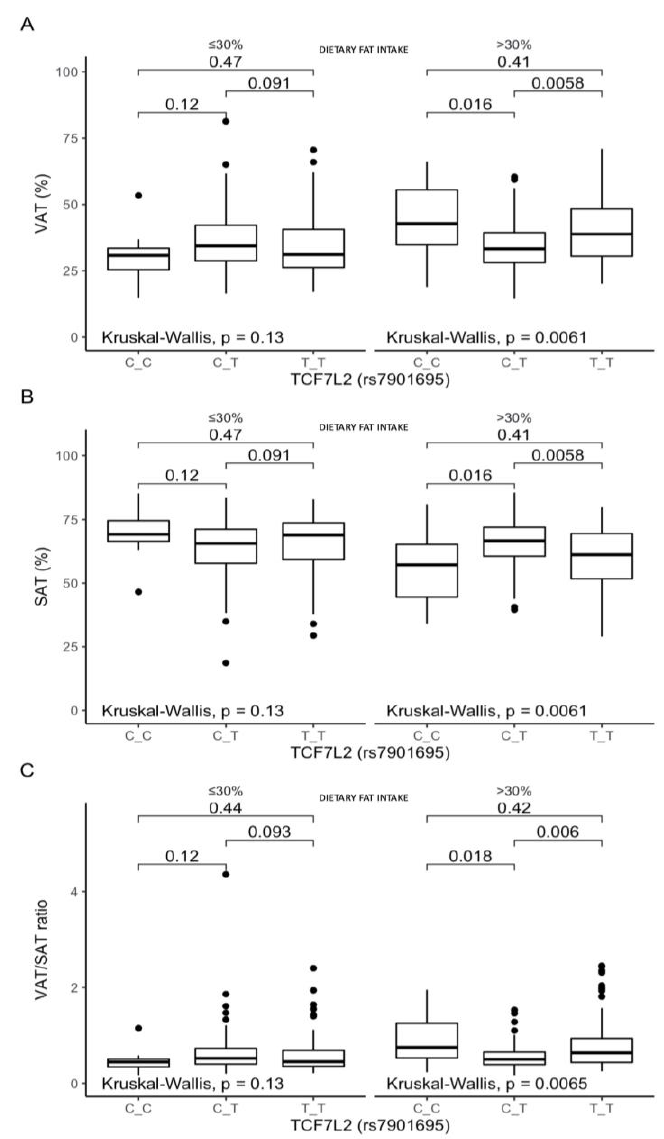
Figure 5. Association of the TCF7L2 rs7901695 genotypes with ( A ) VAT (%), ( B ) SAT (%), and ( C ) VAT/SAT ratio, by dietary fat intake strata: ≤30% and >30% of total daily energy intake. The differences in median values of the selected responses and the interquartile ranges (IQRs) in different genotypic and dietary strata are presented. Kruskal–Wallis test p -values for the differences of median values within three strata are presented.